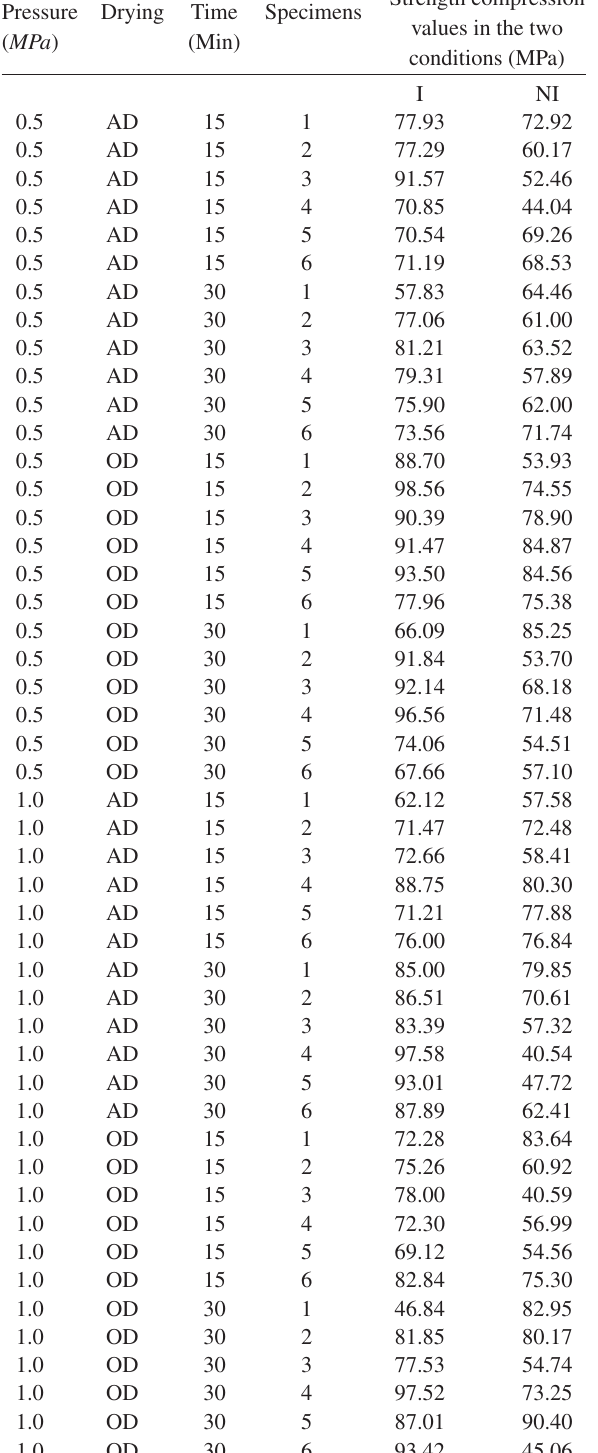
nonimpregnated and impregnated with a monocomponent resin.